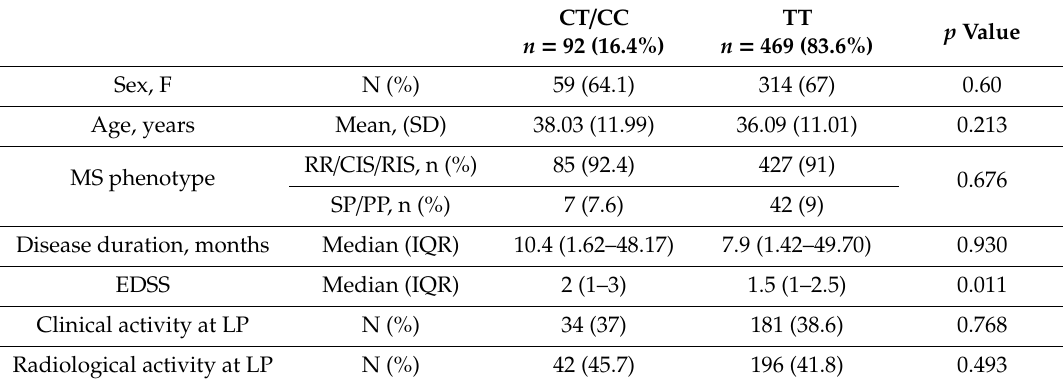
Table 2. Demographic and clinical characteristics of MS patients according to SNP rs244072 group.